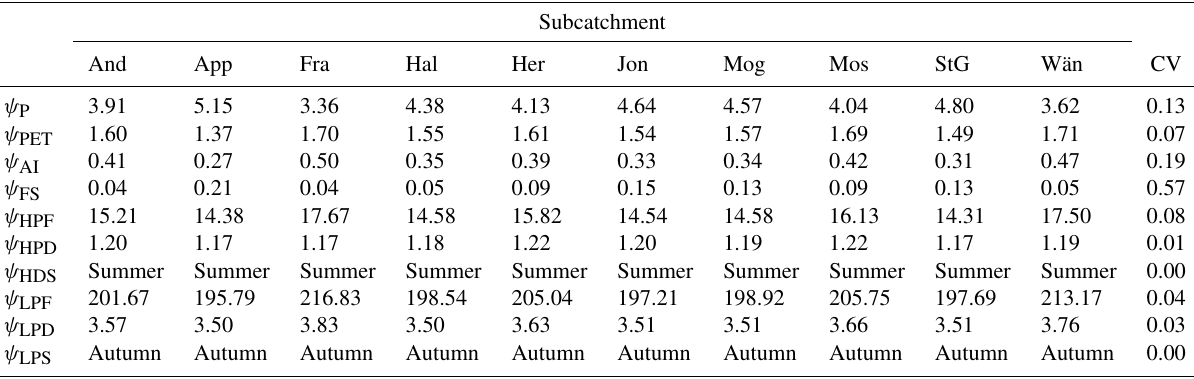
Figure 2. Internal correlation between the streamflow signatures. The lower triangle shows Spearman’s rank score with the red colour that indicates negative correlations and the blue that indicates positive correlations. The upper triangle reports the corresponding p values, where yellow colour indicates a statistically significant correlation ( p value < 0.05). The symbols used in the figure are reported in Table 2. Table 4. Values of the climatic indices. The names of the subcatchments are abbreviated using the first three letters and the symbols are reported in Table 2. The last column contains the coefficient of variation of each